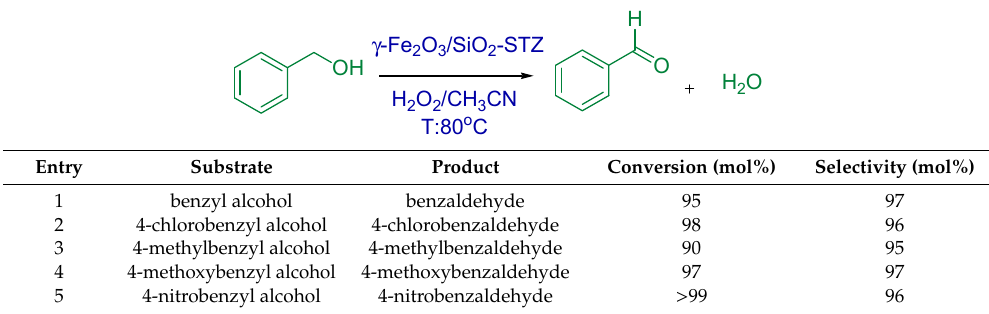
Table 3. Catalytic oxidation of di ff erent benzyl alcohol derivatives by γ -Fe 2 O 3 / SiO 2 -STZ.